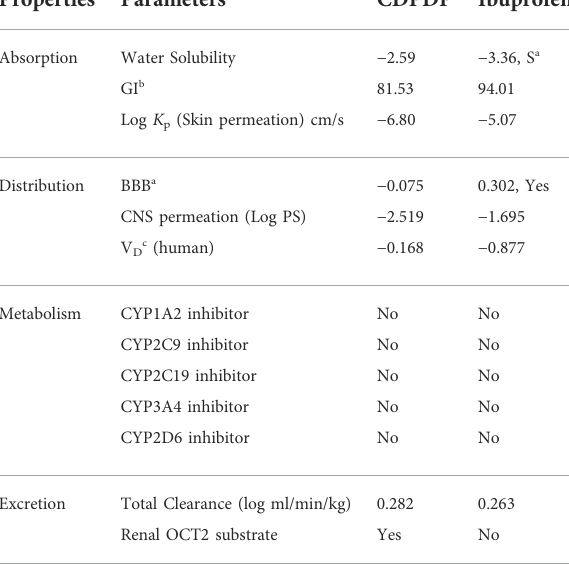
TABLE 7 Predicted pharmacokinetics parameters of CDPDP and